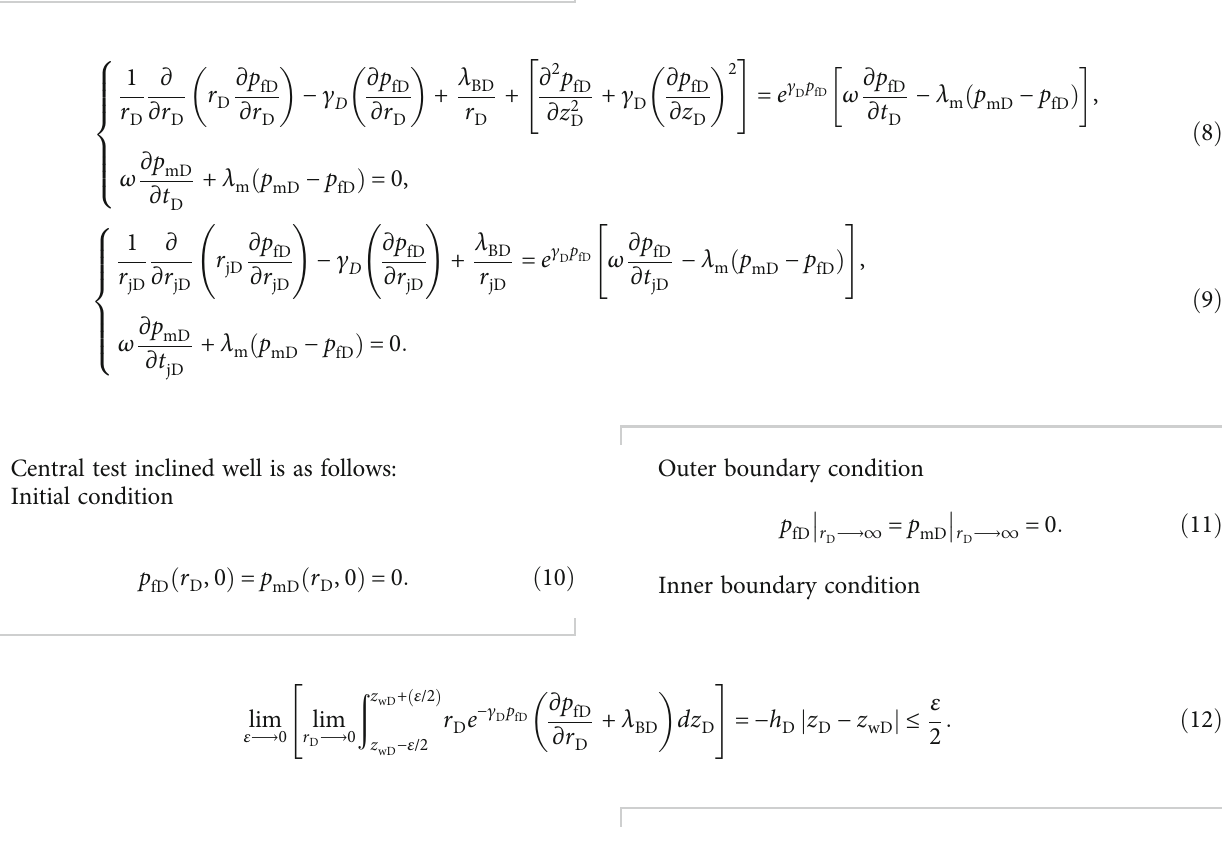
p ffiffiffiffiffiffiffiffiffiffiffiffiffiffiffi : K / K fh fv